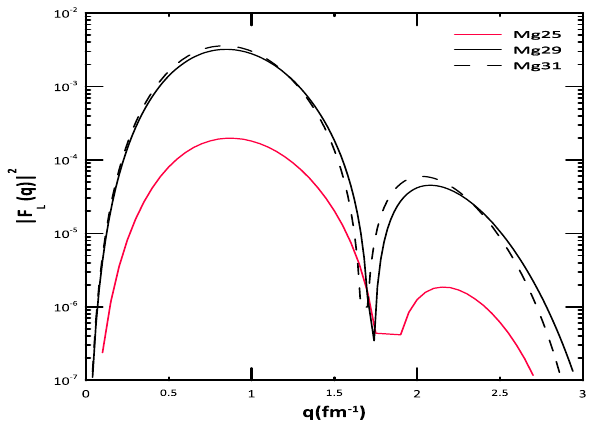
Fig. 8: The relation between moment transfer and longitudinal form factor for 25,29,31 Mg nuclei.